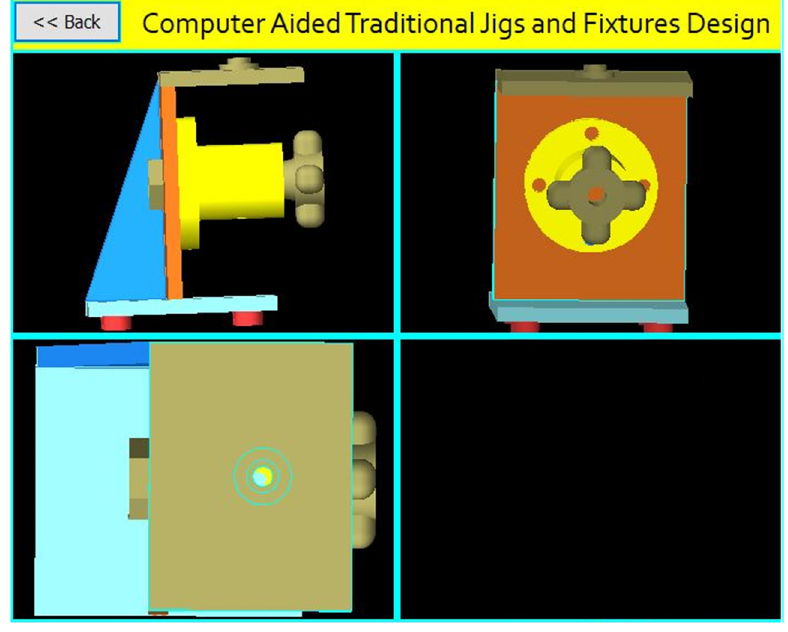
Figure 43. The jig views. A Jig Design for a Cylindrical Part with an Offset Cross